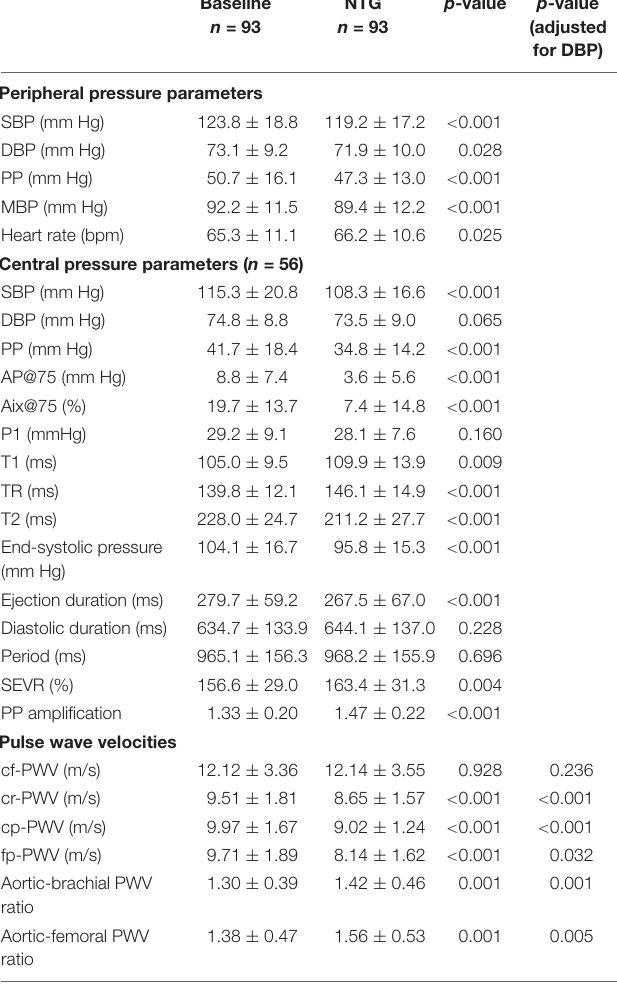
TABLE 1 | Characteristics of patients for control group, CKD group, and overall. Overall